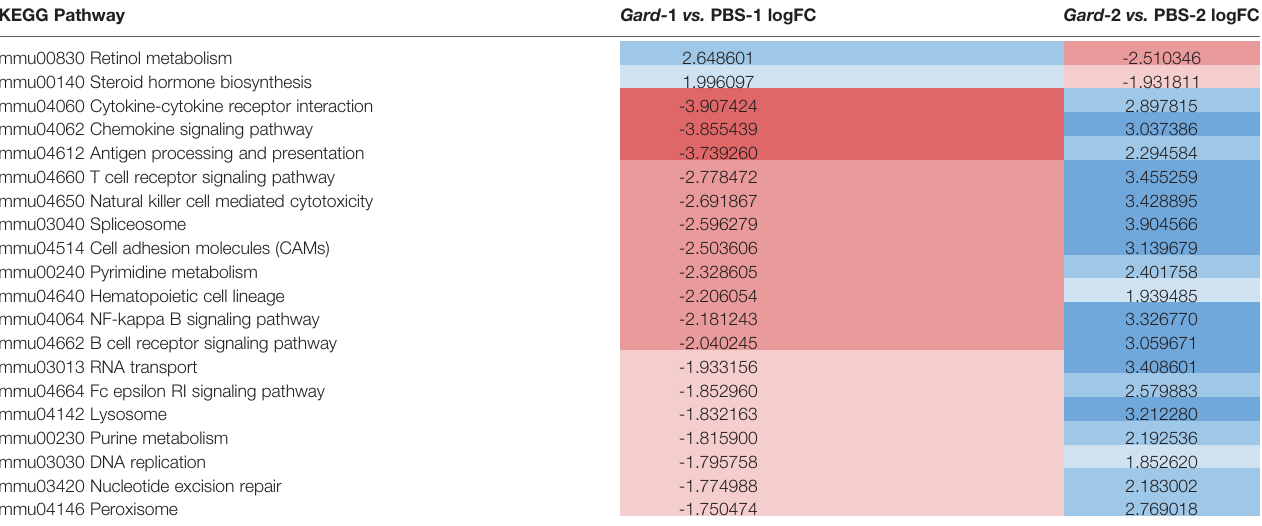
TABLE 2 | Temporal Dynamics of Pathway Expression Following Gardnerella Exposures. KEGG Pathway Gard- 1 vs. PBS-1 logFC